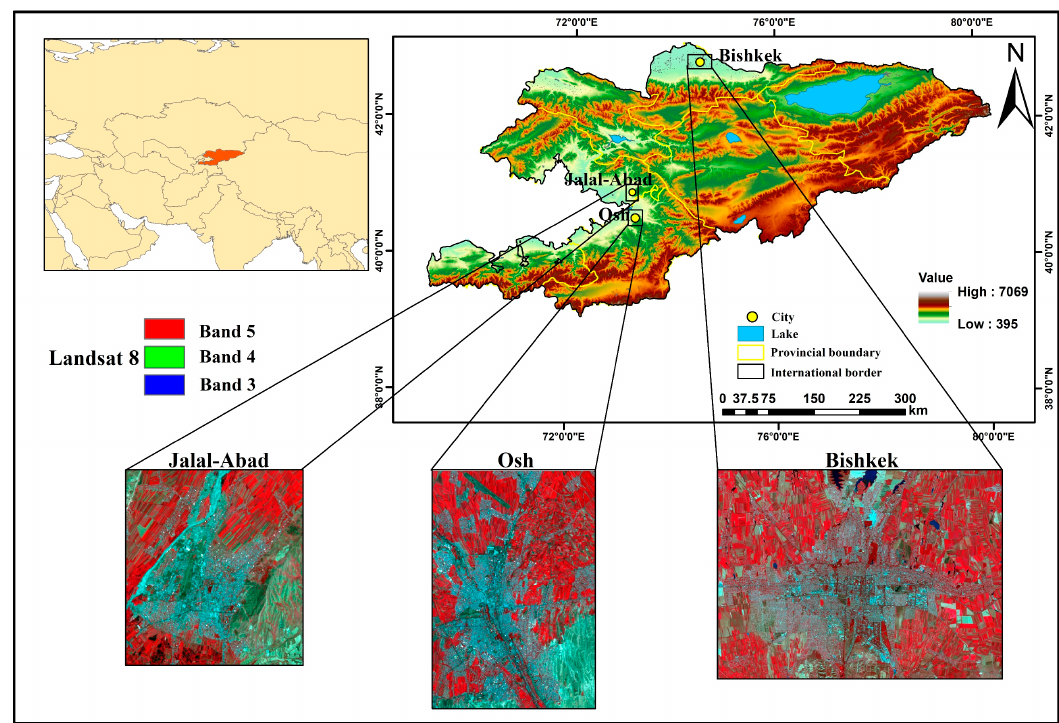
Figure 1. Location of the study area.